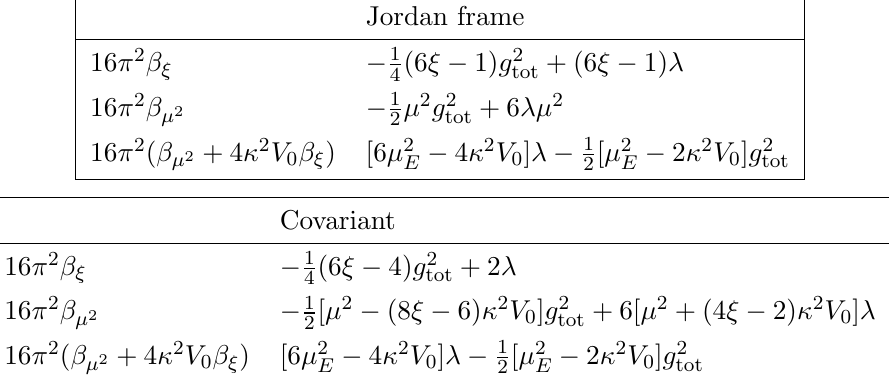
Table 3 . W and Z vector boson contributions to the (cid:12) (cid:0) functions for the curvature coupling and the mass of a gravity coupled scalar (cid:12)eld at leading order in (cid:20) 4 V 0 . The Jordan frame result has been calculated directly from the original action. The covariant result uses a geodesic expansion on (cid:12)eld space and is independent of the frame used. The renormalisation group (cid:13)ow of (cid:22) 2 is the same for each of these approaches.